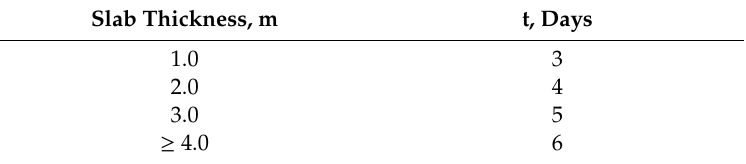
Table 8. The suggested age of concrete for the estimation of the modulus of elasticity E cm ( t )